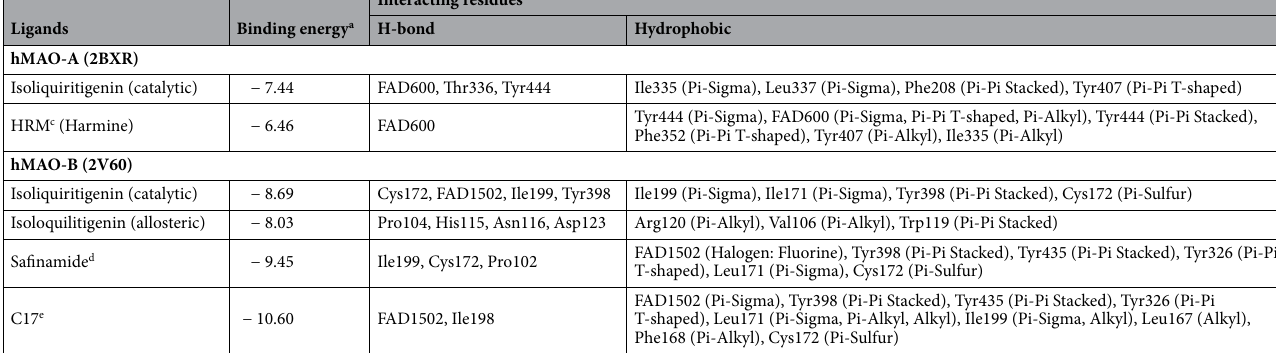
Table 2. Binding energy and interacting residues during the inhibition of hMAO-A and hMAO-B by isoliquiritigenin and reference ligands. a The estimated binding energy (kcal/mol), which signifies the binding affinity of a ligand to the active site of hMAO-A and hMAO-B. b The interacting amino acid residues in the ligand-enzyme complex were determined using the AutoDock 4.2 program. c Harmine, reference ligand; 7-methoxy-1-methyl-9H-pyrido[3,4-b]indole. d Safinamide, reference reversible hMAO-B inhibitor; (2 S )-2-[[4- [(3-fluorophenyl)methoxy]phenyl]methylamino]propenamide. e C17, reference ligand; N7-[(3-chlorophenyl) methoxy]-2-oxochromene-4-carbaldehyde.